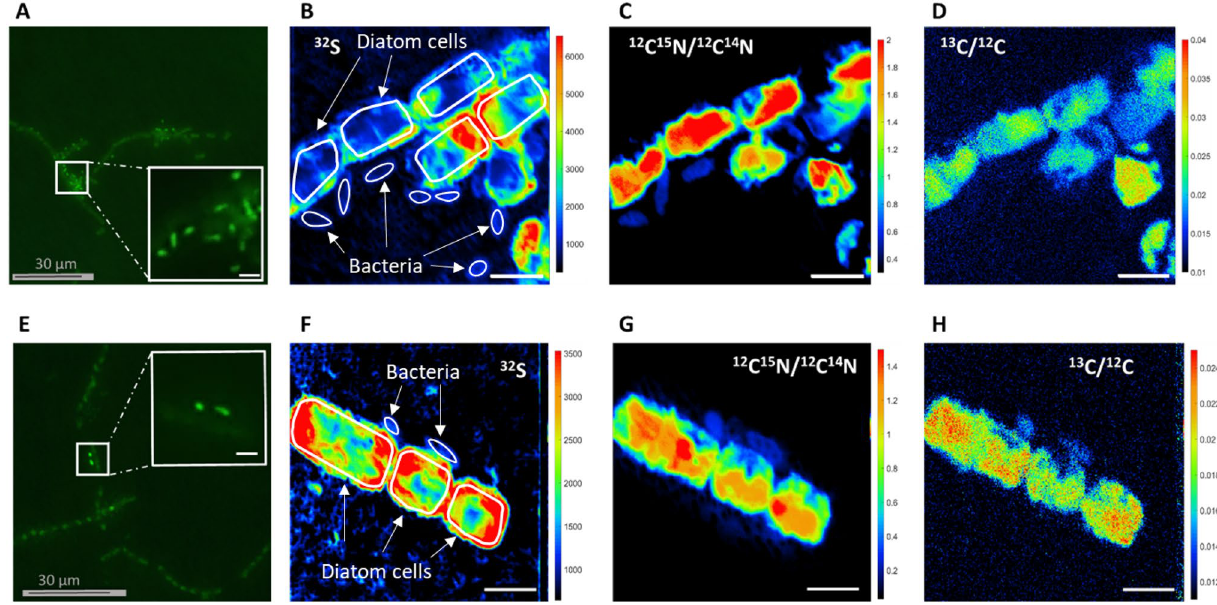
Figure 2. Correlative CARD-FISH and nanoSIMS imaging of Alteromonas ( A – D ) and Pseudoalteromonas spp. ( E – H ), sampled at 72 h. ( A , E ) Fluorescence micrographs acquired after CARD-FISH but prior to the nanoSIMS analysis; the contoured insets represent a zoom-in of the fields of view (FoV) that are shown in the nanoSIMS images ( B – H ). B – C – D and F – G – H represent the chemical maps acquired during the nanoSIMS analysis for Sulfur ( 32 S), as an indicator of biomass, 12 C 15 N/ 12 C 14 N and 13 C/ 12 C for quantifying the nitrogen and carbon enrichment, respectively. Contours of diatom cells and bacteria are drawn in panels B and F only. Scale bars in the insets and chemical maps are 3 µm.